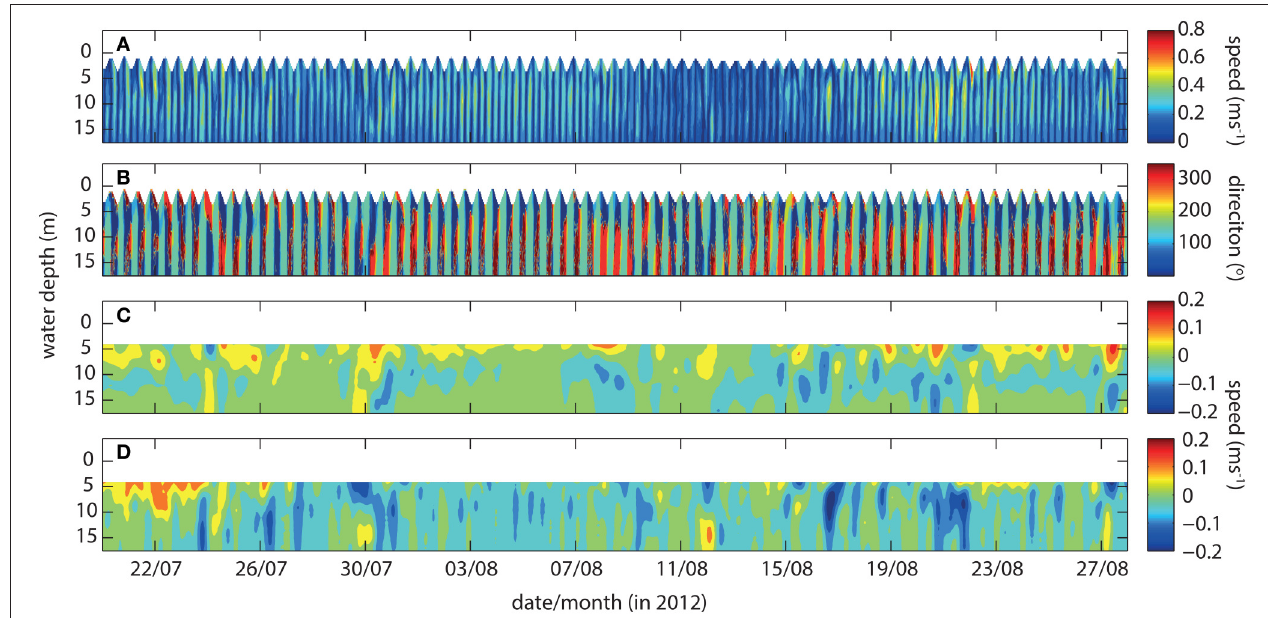
FIGURE 6 | ADCP observations from WilsonB showing (A) current speed, (B) current direction and low-pass filtered currents in (C) for u-direction, and (D) v-direction.